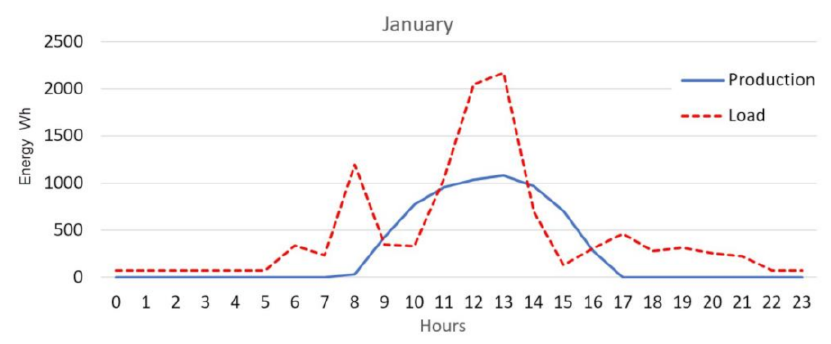
Figure 9. Load and energy production at the average daily level for January. Table 6. Energy production and load at the average daily level for